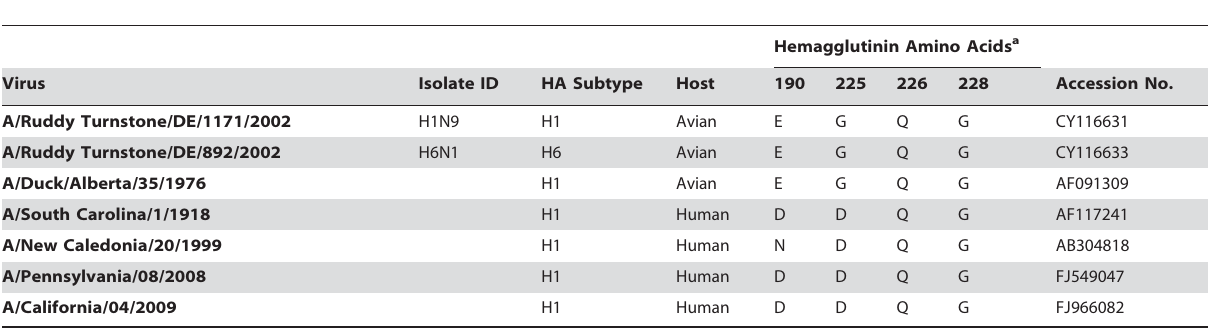
Table 3. Comparison of critical amino acids involved in receptor specificity of influenza hemagglutinin.